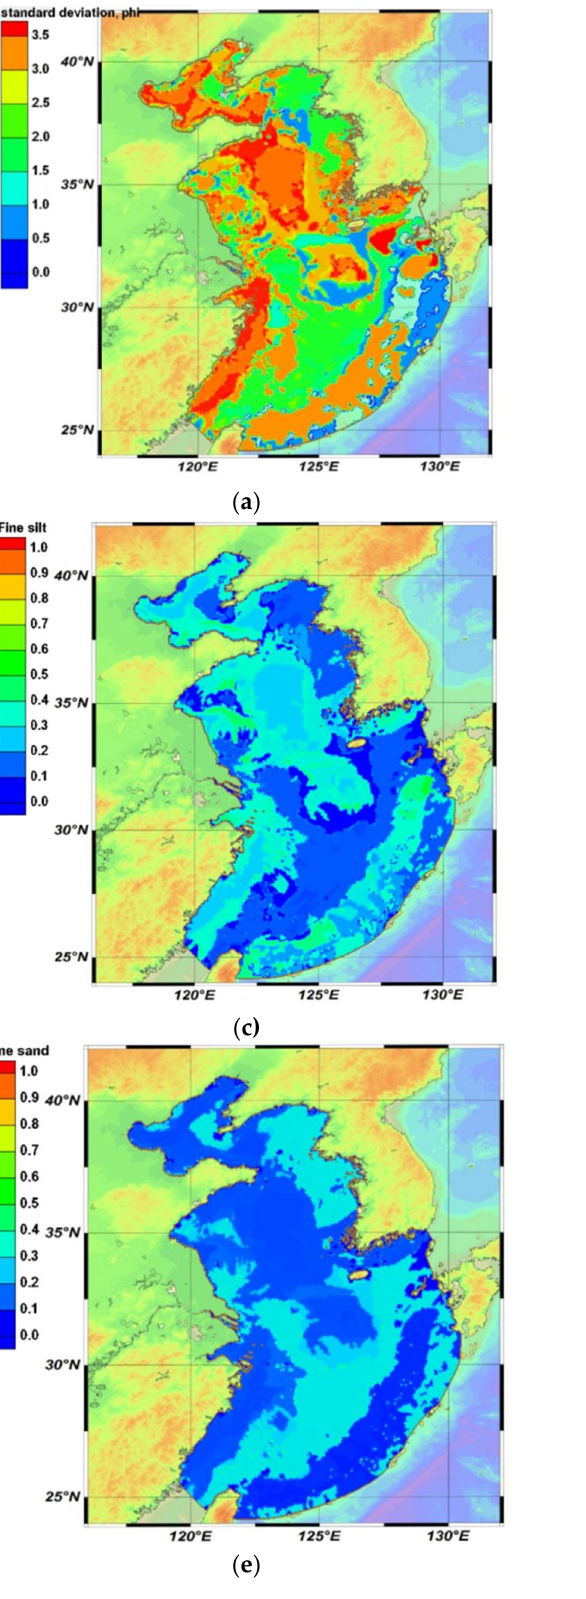
 ; ( b ) clay fraction; ( c ) fine silt fraction; ( d ) coarse silt fraction; Figure 5. ( a ) Standard deviation  Figure 5. ( a ) Standard deviation σ φ ; ( b ) clay fraction; ( c ) fine silt fraction; ( d ) coarse silt fraction; ( e ) fine sand fraction; ( f ) coarse sand fraction. ( e ) fine sand fraction; ( f ) coarse sand